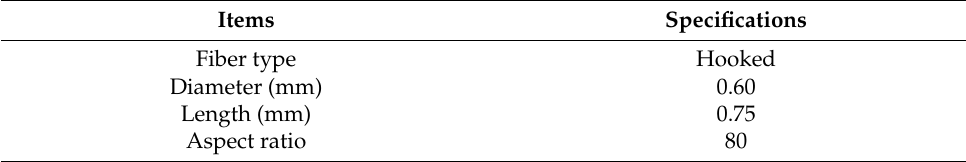
Table 2. Specifications of hooked steel fibers.